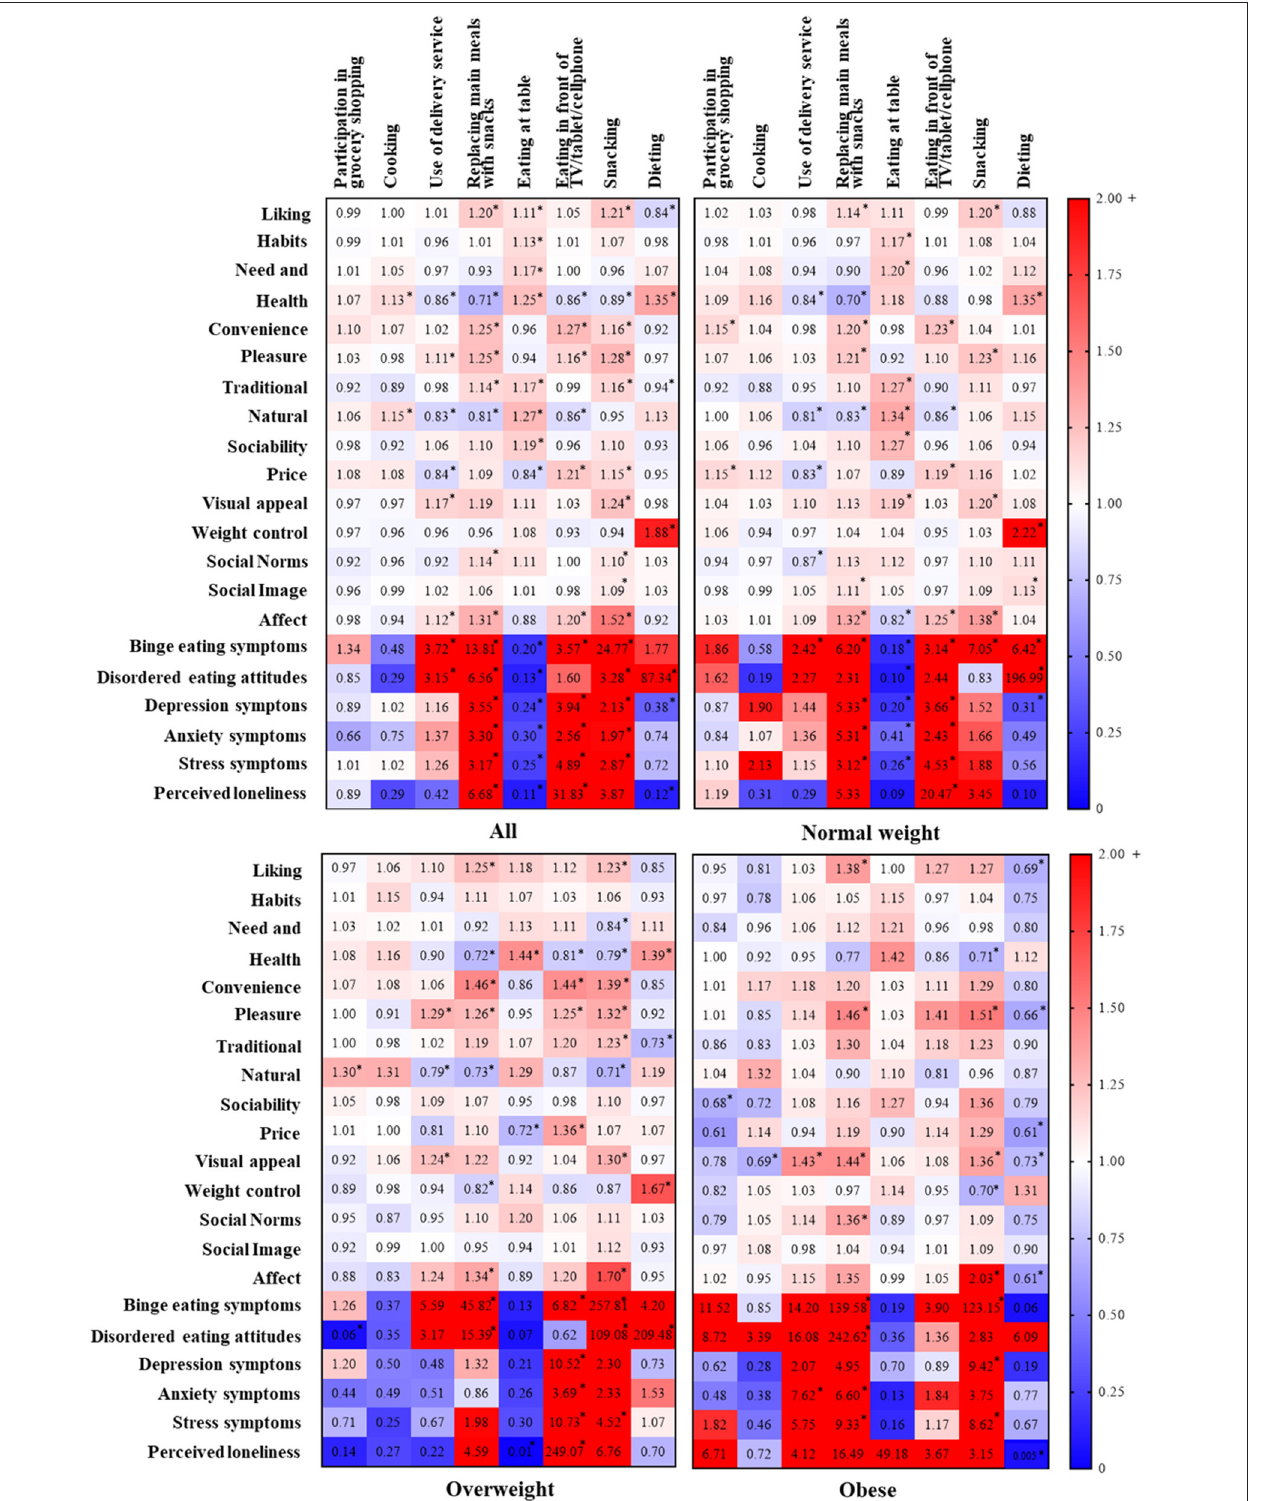
Frontiers in Nutrition |